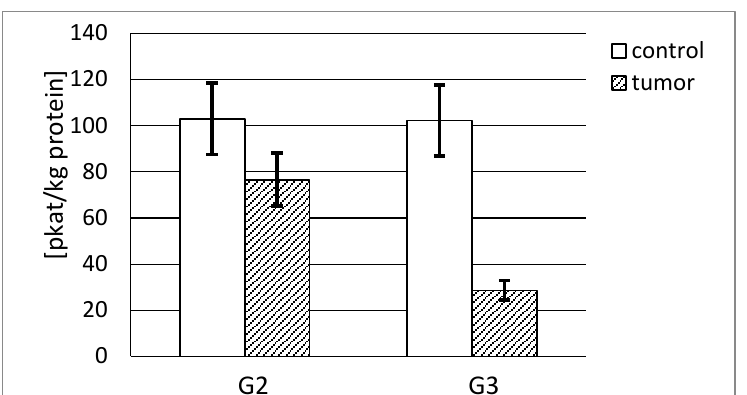
Figure 6. MMP-3 actual activity in human kidney tumor (G2 grade and G3 grade) and respective control tissue. p < 0.001—cancer vs. respective control kidney; p < 0.001—G3 grade vs. G2 grade human kidney cancer.